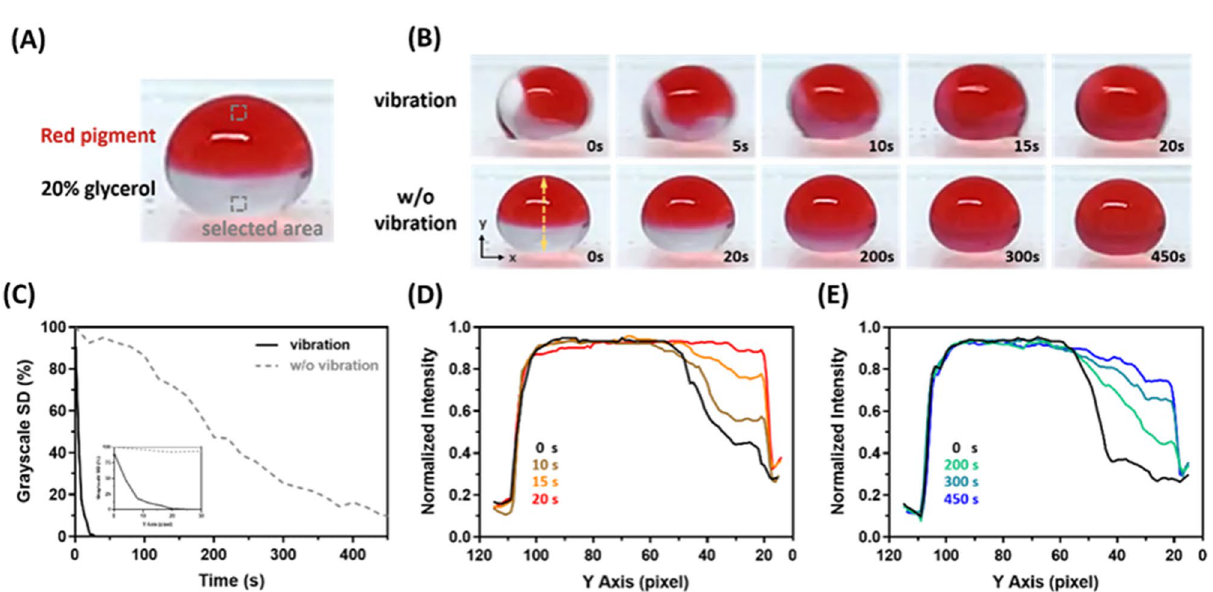
Figure 3. ( A ) The droplet mixture uses a red pigment and 20% glycerol to demonstrate. ( B ) Time-lapsed images of the droplet mixing process. ( C ) Calculating the selected area for the standard deviation of the grayscale image indicates the droplet mixing efficiency, and the distributions of normalized intensity along the yellow dashed line ( B ) indicate the color of the mixture droplet changing over time with ( D ) and without ( E )